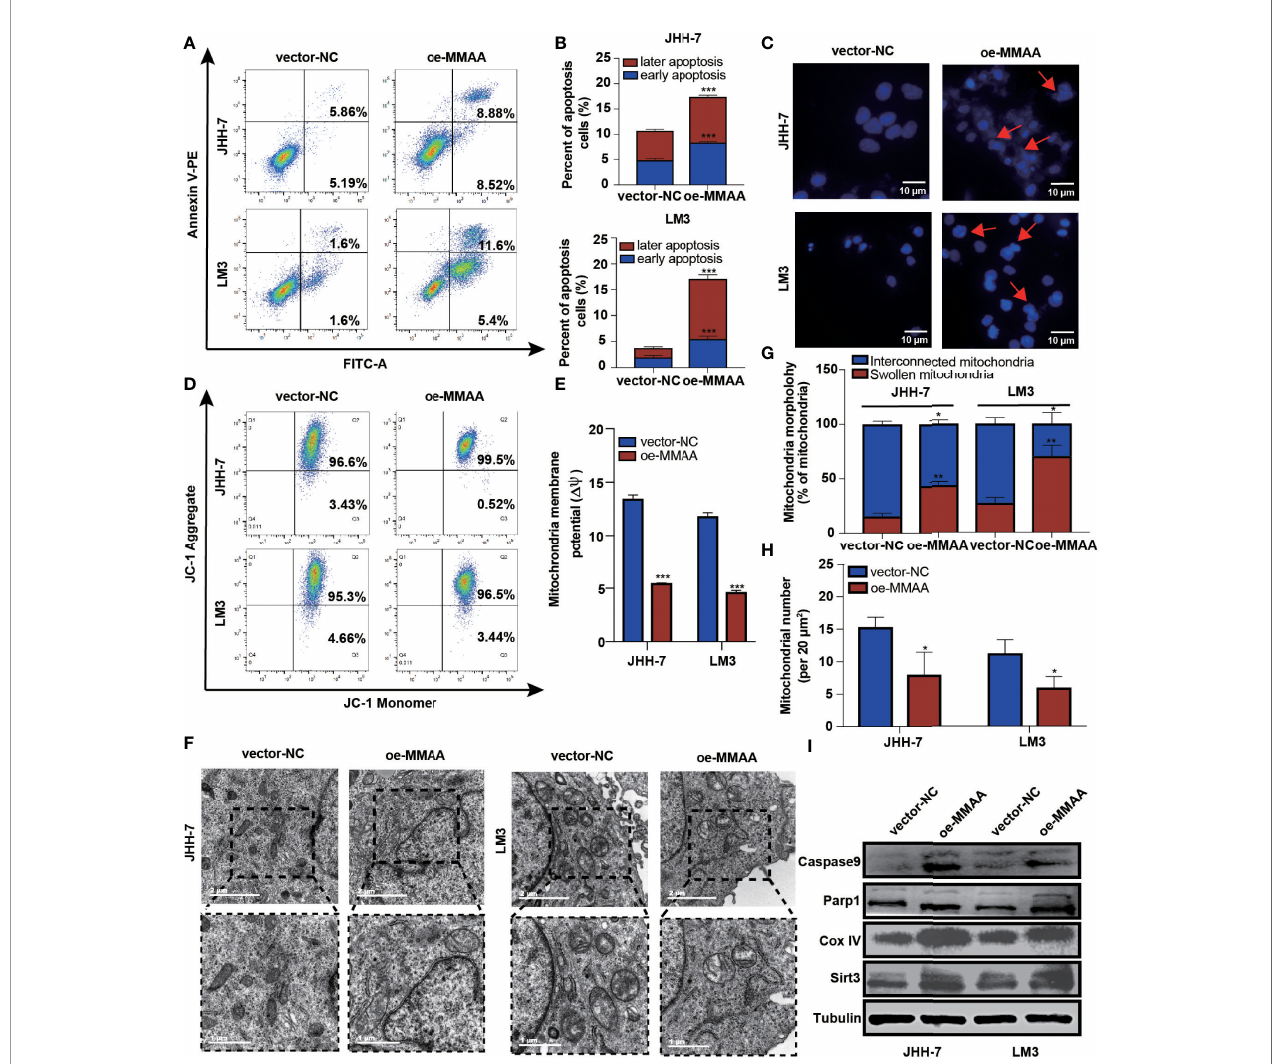
FIGURE 4 | The loss of metabolism of cobalamin-associated A (MMAA) is required for cell proliferation and migration in hepatocellular carcinoma (HCC) in vitro . (A) Apoptosis rates of the MMAA-overexpressing cell lines compared with vector- NC ; quanti fi cation of the data is presented in (B) . (C) Increased apoptosis in OE- MMAA HCC cell lines was accompanied by shrinkage of the nucleus morphology (scale bar, 10 µm). (D) Mitochondrial potential was measured by detecting the JC-1 decrease in JHH-7 and LM3 cells overexpressing MMAA. The decrease in mitochondrial potential was quanti fi ed in (E) as mean ± SD. (F) TEM analysis of the mitochondrial morphology after a stable infection with MMAA in JHH-7 and LM3 cells (scale bars, 2 and 1 µm). (G) Quanti fi cation of the percentages of swollen mitochondria and interconnected mitochondria through TEM data. (H) Quanti fi cation of the number of mitochondria per 20 mm 2 via TEM data. (I) Immunoblot analysis of mitochondria-related protein expression in JHH-7 and LM3 cells infected with MMAA. * P < 0.05, ** P < 0.01, *** P < 0.001; three biological repeats per